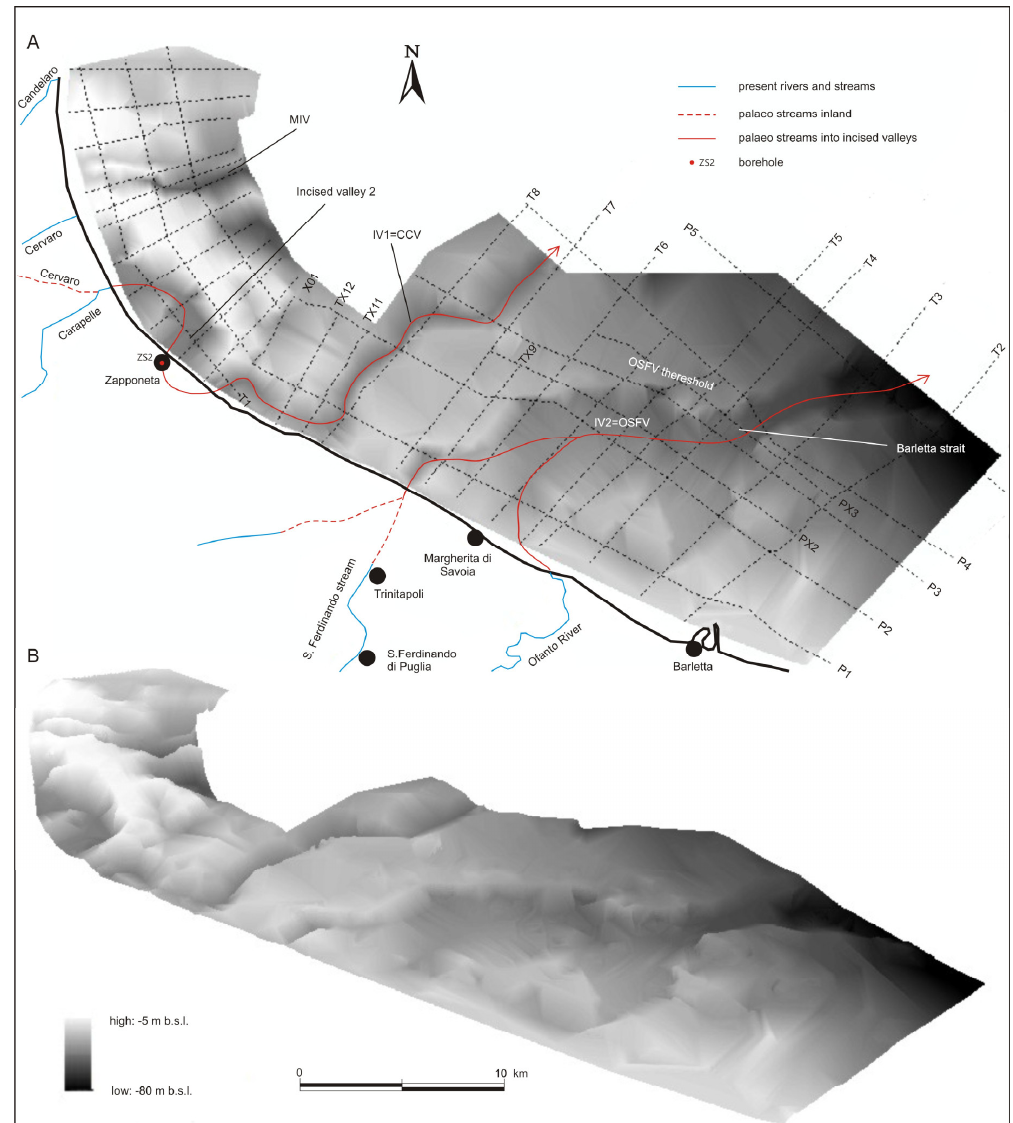
Figure 6. Digital Elevation Model (DEM) of the erosional surface ES1 both in plan view ( A ) and in oblique view ( B ). For the former, seismic profiles and the reconstructed drainage network are also shown. The seismic profiles showed in the following figures are indicated with their names.